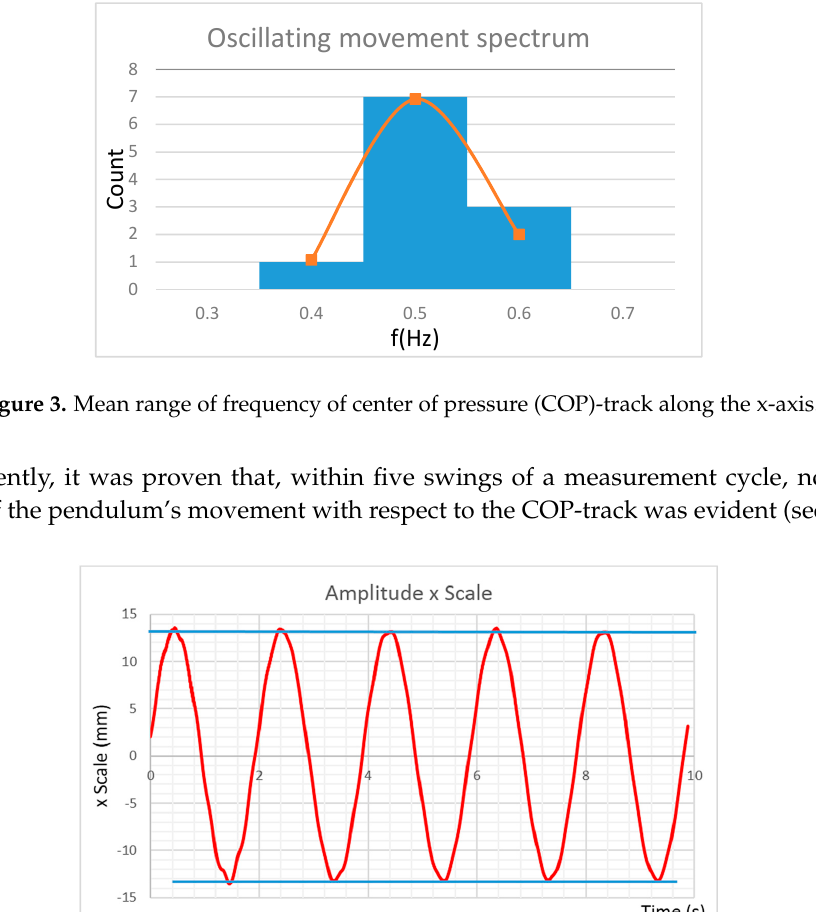
Figure 4 . Dampening behaviour of the pendulum’s movement in a time interval of 10 seconds, within the corresponding envelope (blue).